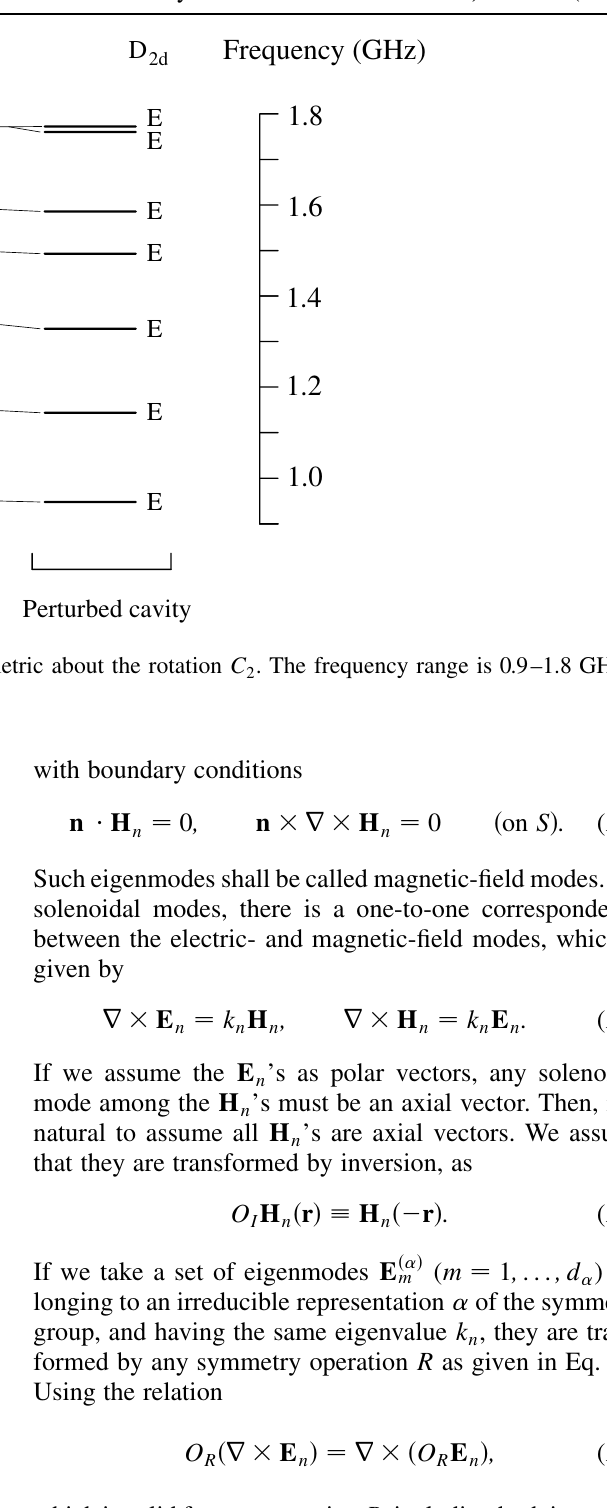
FIG. 10. Calculated spectra of eigenmodes that are antisymmetric about the rotation C